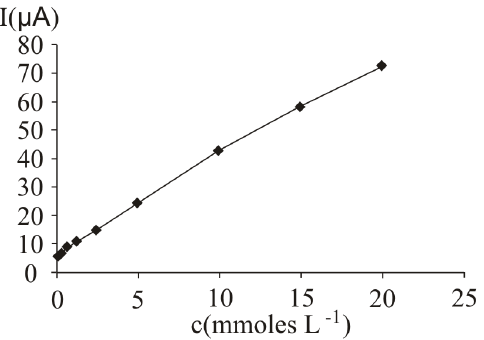
Figure 8. Calibration graph obtained obtained at ascorbic acid determination by differential pulse voltammetry at a carbon paste working electrode; for experimental conditions see Figure